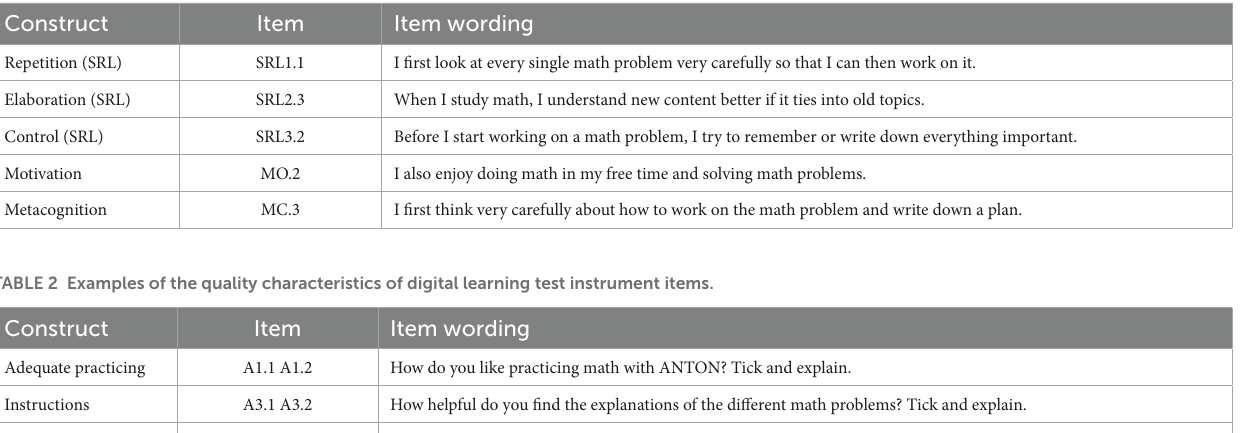
TABLE 1 Examples of the self-regulated learning test instrument